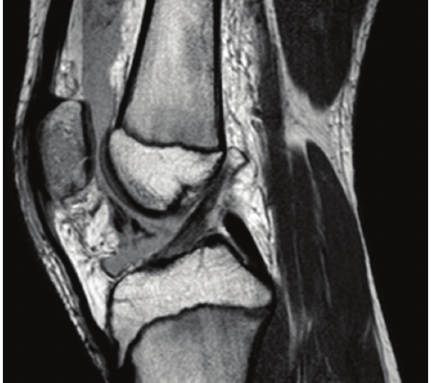
Figure 3: Sagittal T1 weighted magnetic resonance image taken one week after presentation.